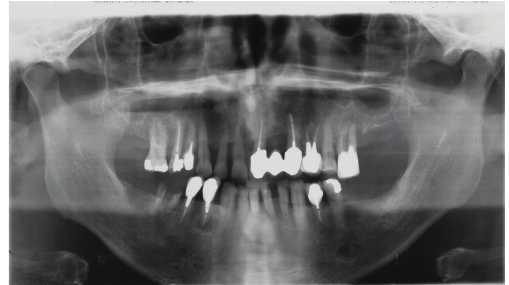
Figure 2: Radiographic image: panoramic radiography showing the extensive bone resorption in the anterior area of the maxilla compatible with advanced periodontal